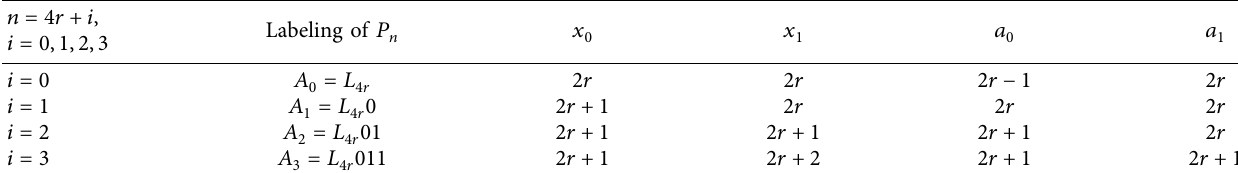
Figure 6: Logical labeling of P Table 1: Labeling of P